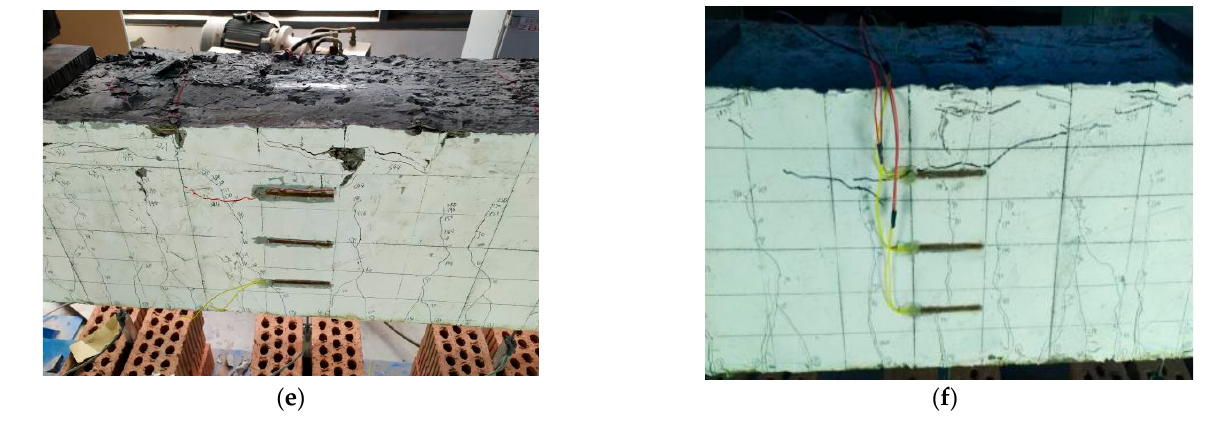
Figure 4. Failure mode of the test beams. ( a ) L-0-0; ( b ) L-0-30; ( c ) L-1/2-30; ( d ) L-1-0; ( e ) L-1-30; ( f ) L-1-45.